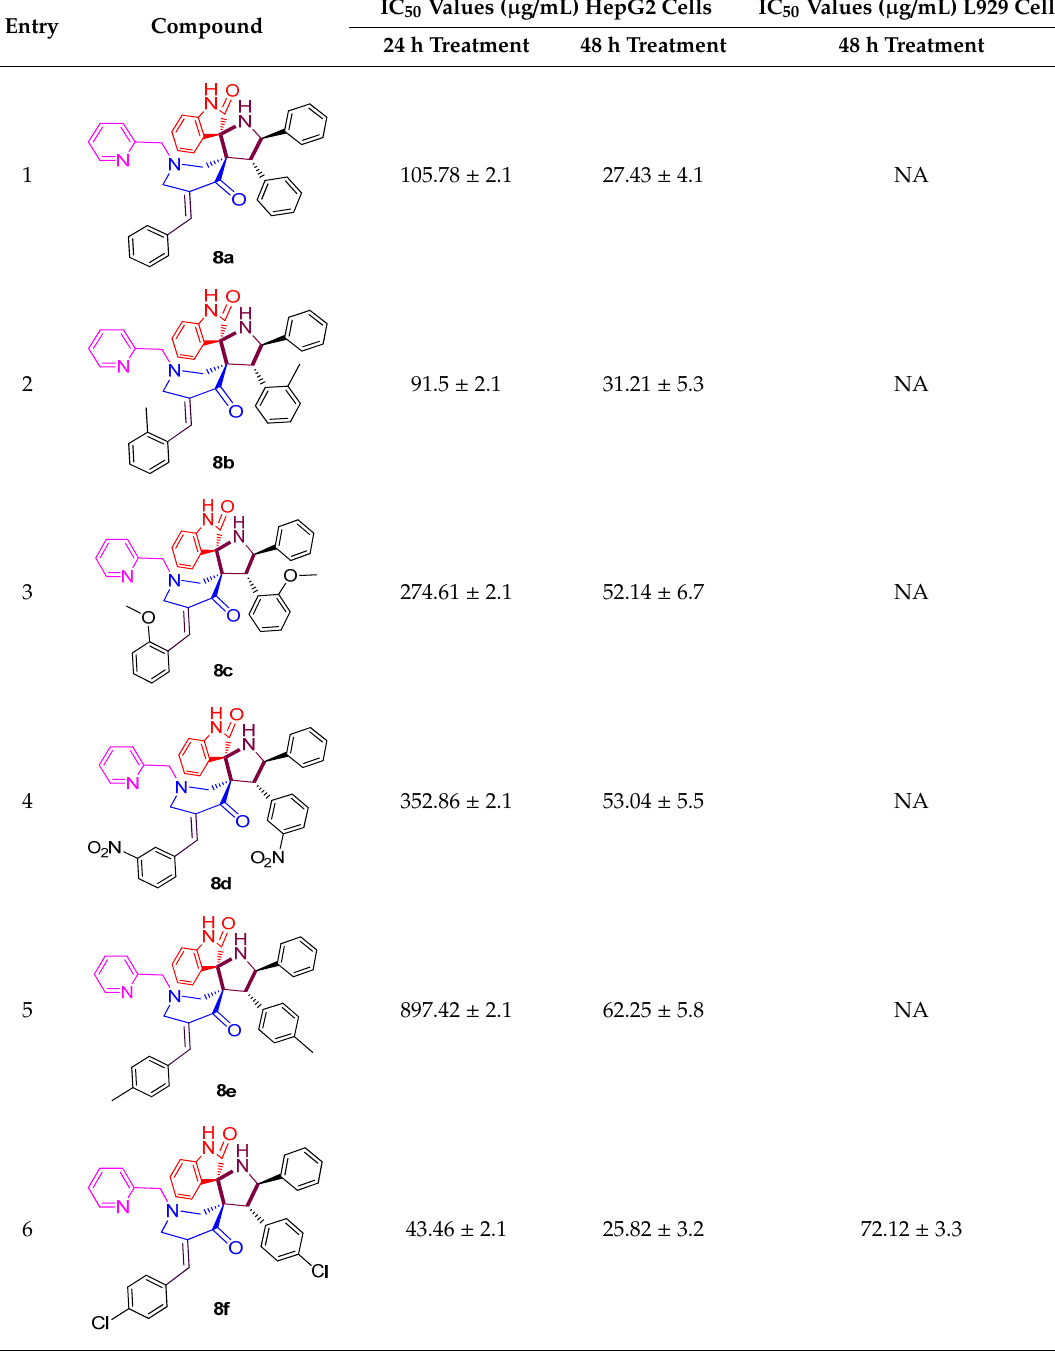
Table 1. Comparison of the concentration required for 50% of cell death (IC 50 ) of the tested compounds 8 ( a – h ) following the treatments to the HepG2 and L929 cells over 24 and 48 h incubation periods. Entry